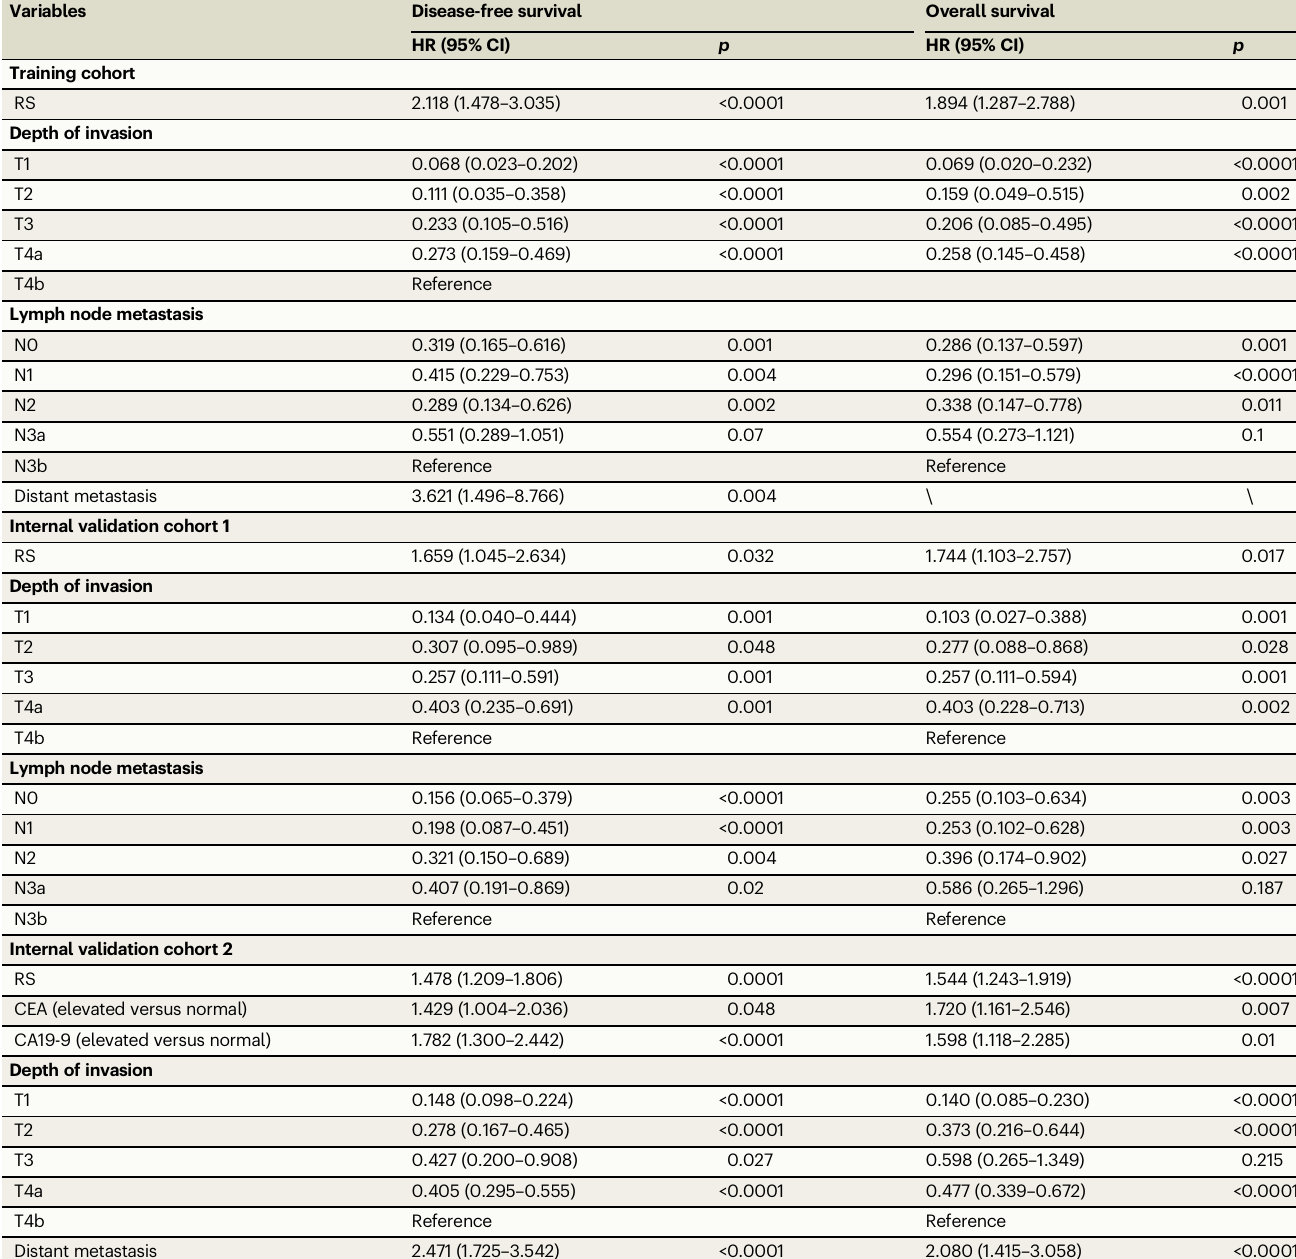
Table2|MultivariateCoxregressionanalysesfordisease-freesurvivalandoverallsurvivalin patientswithgastriccancerinthe training and internal validation